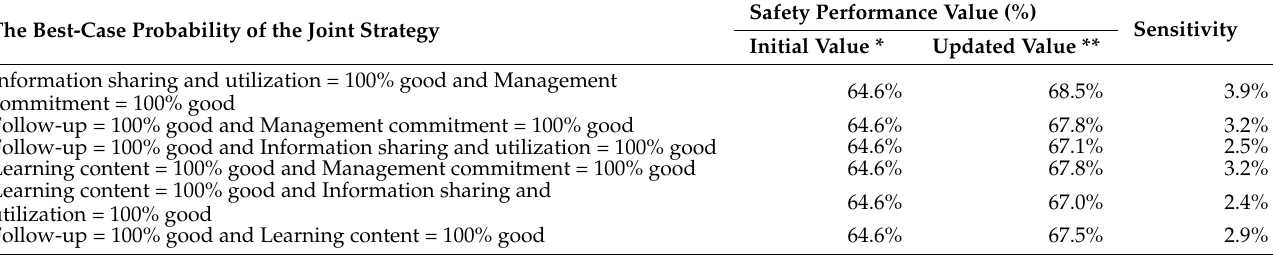
Table 12. Sensitivity (%) of the joint strategy to improve safety